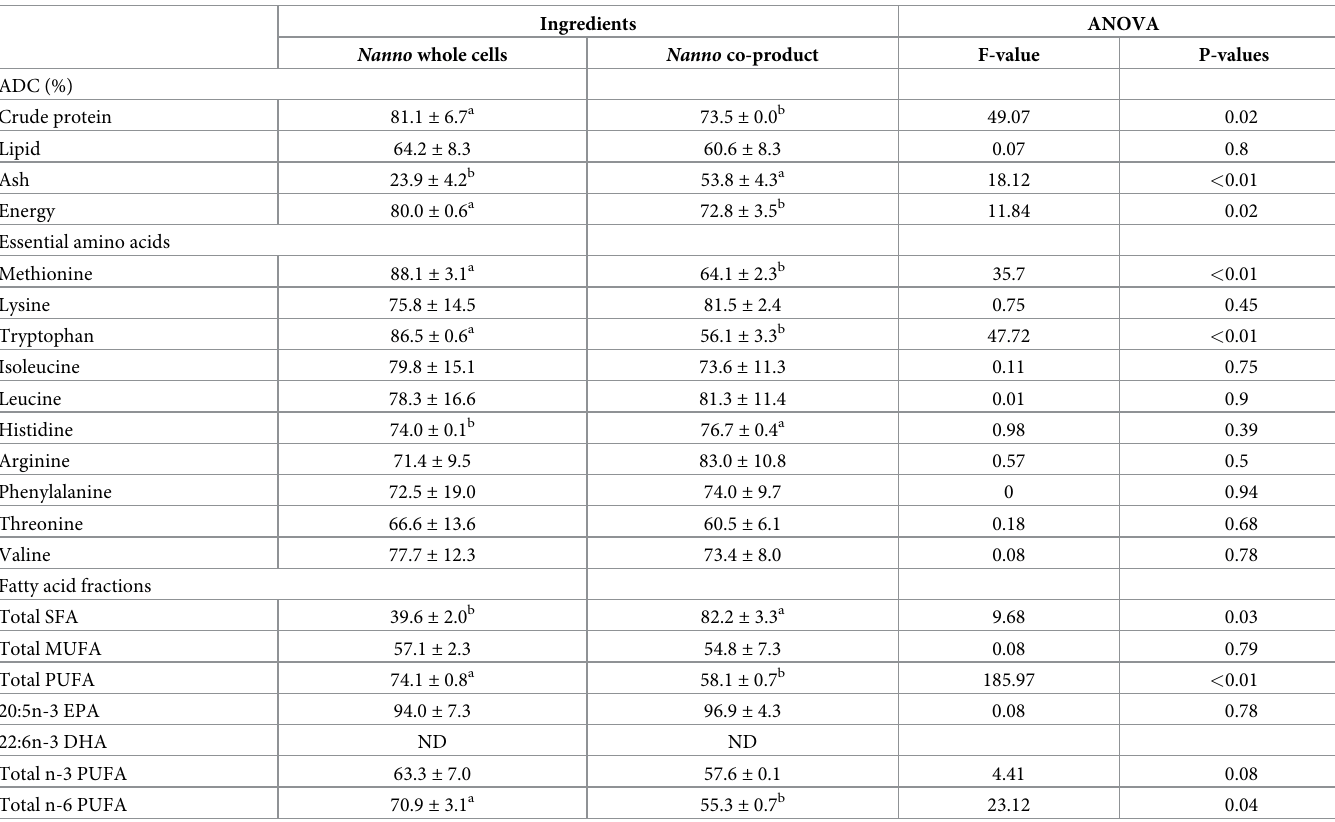
Table 10. Test ingredient apparent digestibility coefficients (ADC test ingredient) (cid:3) of nutrients, gross energy, essential amino acids and fatty acids in Nannochloropsis oculata – whole cells ( Nanno whole cells) and Nannochloropsisoculata –co-product ( Nanno co-product) for tilapia.